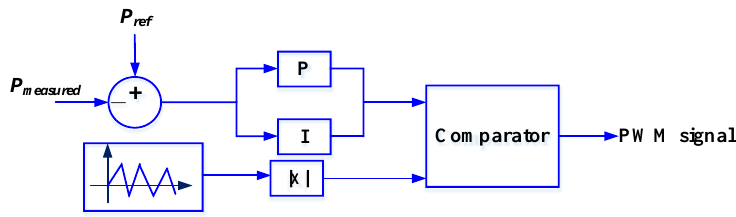
Figure 7. Active power controller.